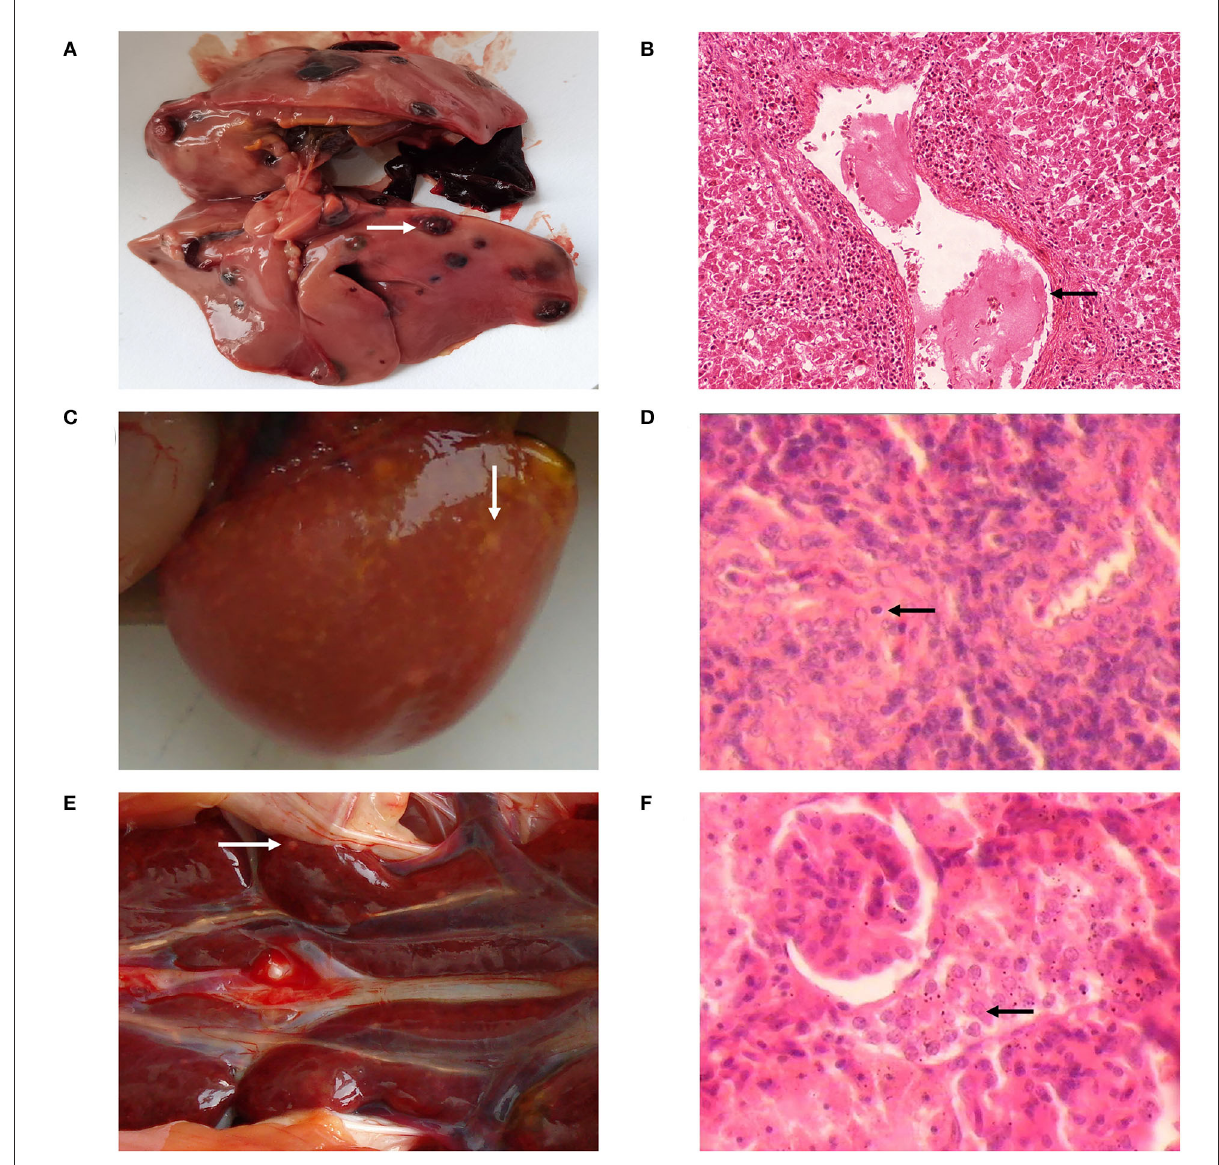
FIGURE9 Anatomical and histological lesions. (A) Hemangioma on the liver surface. (B) Vascular endothelial hyperplasia, HE, 40 × . (C) Lesions on the surface of the spleen. (D) Proliferation of capillary vessels, HE, 400 × . (E) Kidney enlarged with multifocal lesions. (F) Kidney cells without nucleolus, HE, 400 ×